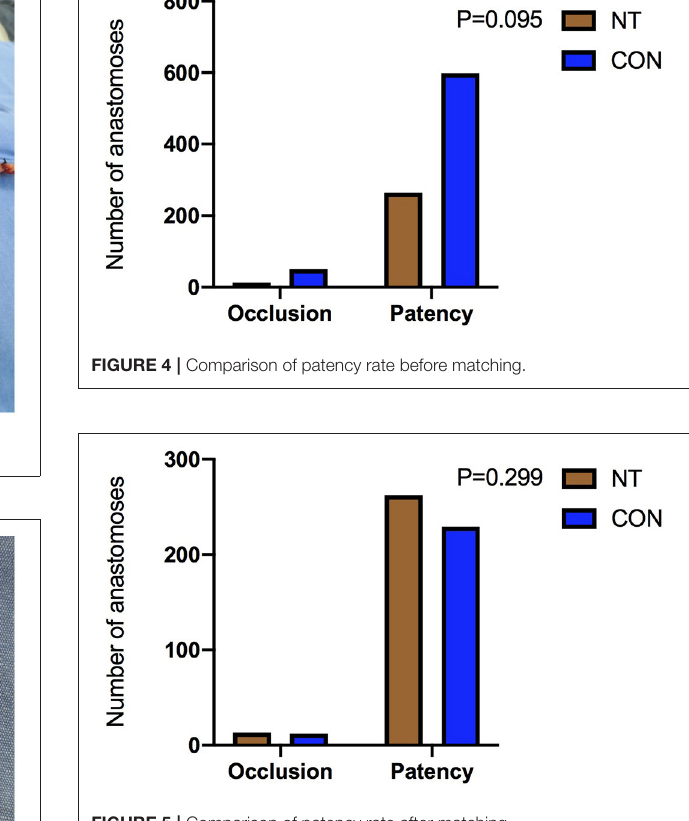
FIGURE 5 | Comparison of patency rate after matching.